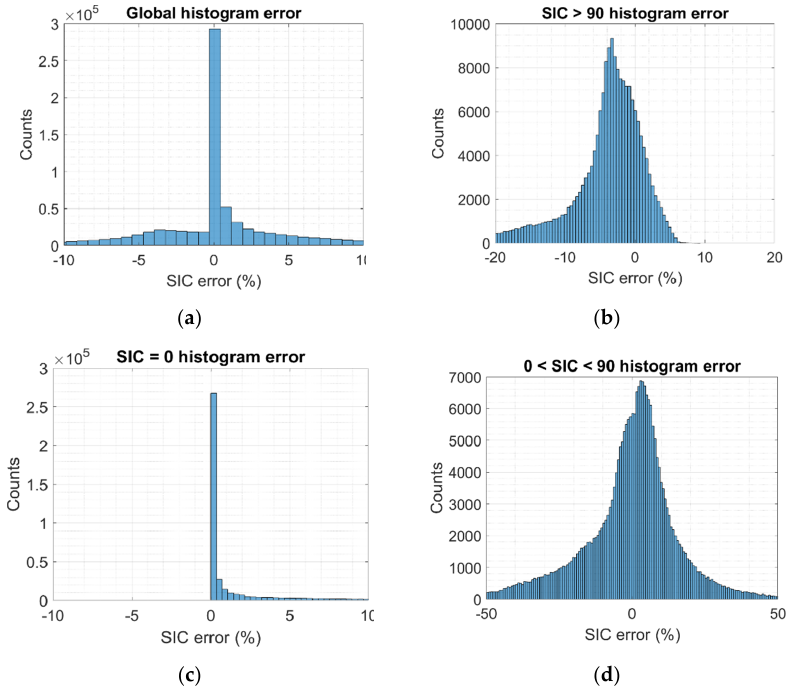
Figure 10. Arctic SIC MWR error histogram: ( a ) Global, ( b ) SIC > 90%, ( c ) SIC = 0 ( d ) 0 < SIC < 90.